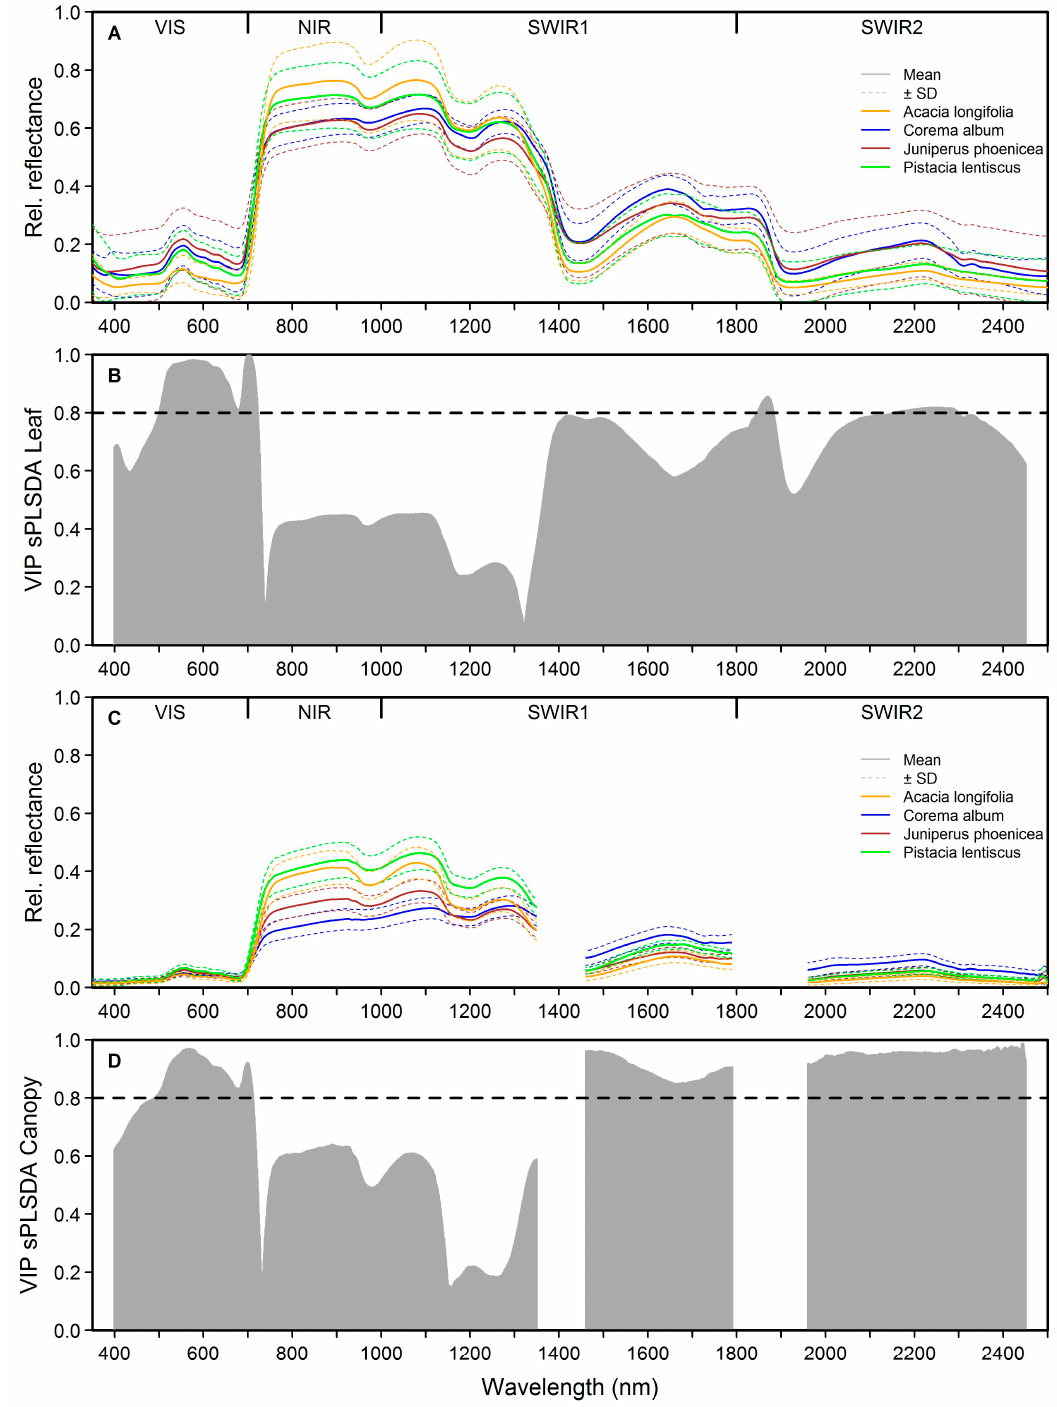
Figure 3. Field spectra and medians of Variable Importance (VIP) (100 iterations) of classification models of Acacia longifolia : ( A ) mean leaf spectra of A. longifolia and co-occurring native species; ( B ) VIP of sparse Partial Least Squares Discriminant Analysis (sPLSDA) using the full spectrum at leaf level; ( C ) mean canopy spectra of A. longifolia and co-occurring native species; and ( D ) VIP of sparse Partial Least Squares Discriminant Analysis (sPLSDA) using the full spectrum at canopy level. VIP values > 0.8 (dashed lines) indicate highly important predictors.